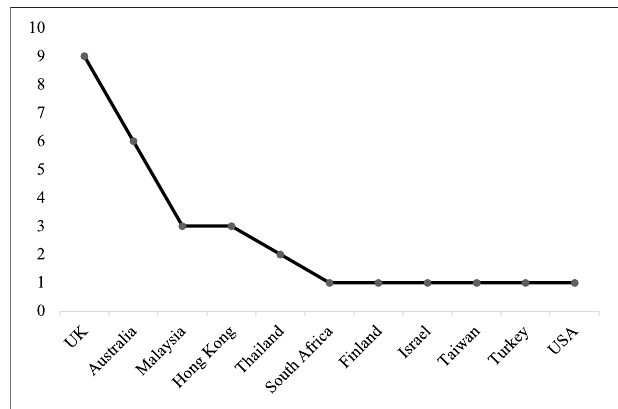
FIGURE 2 | Number of papers per